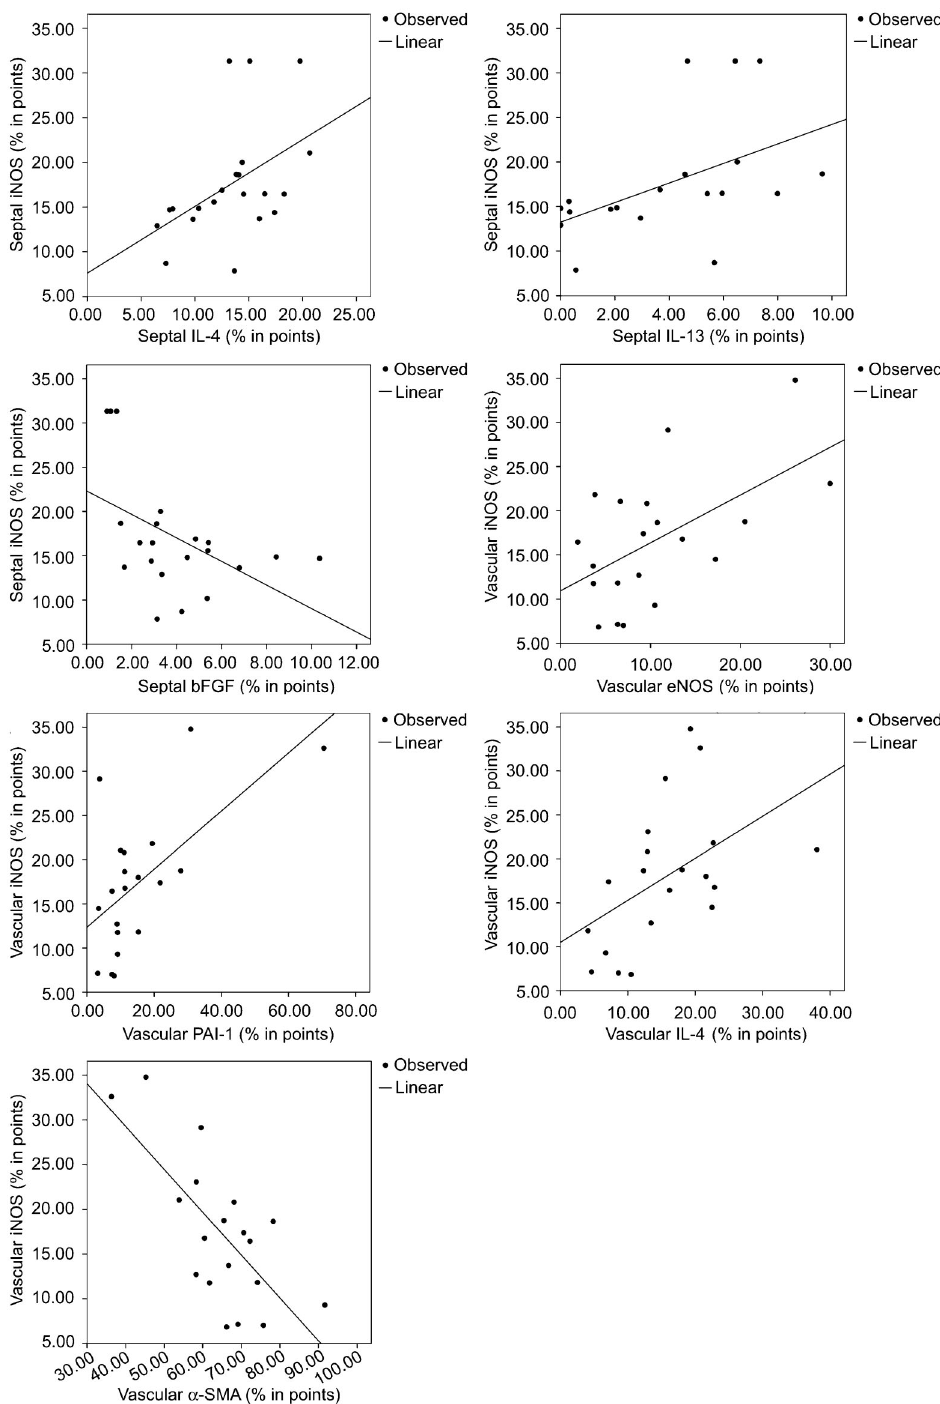
Figure 5. Scatter plots show the relationship between staining of septal and vascular cells for iNOS and IL-4, IL-13, bFGF, eNOS, PAI-1, and a